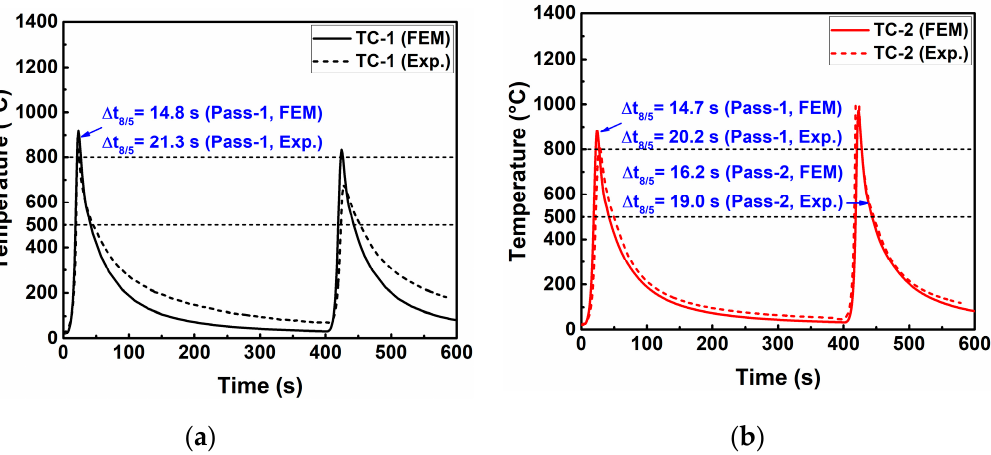
Figure 11. Comparison of the thermal cycle between experiment and FEM (case B-1): ( a ) At TC-1 location; ( b ) at TC-2 location. Table 5. Phase percentages referring to a node at the middle of FZ. Phase Fraction (wt.%)